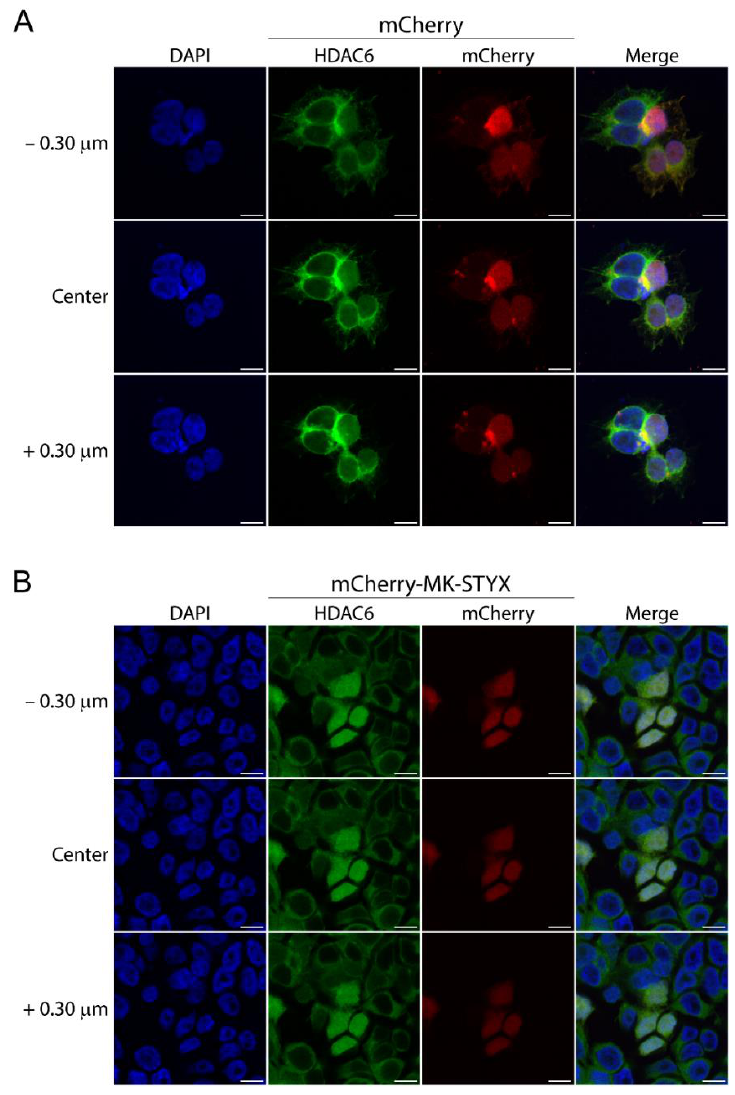
Figure 2. Confocal microscopy validates that the subcellular distribution of HDAC6 is altered in the presence of MK-STYX. ( A ) Representative examples of the subcellular distribution of endogenous HDAC6, detected with an anti-HDAC6 antibody (anti-HDAC6) and anti-rabbit conjugated to FITC in HEK/293 cells, cultured in the presence of serum and transfected with mCherry (control vector) or ( B ) mCherry-MK-STYX. Z-stacks at 0.15 µ m were performed by confocal microcopy, starting below the center of the cells. Representative images are shown above ( − 0.30 µ m) and below (+0.30 µ m) the center image. Scale bar, 10 µ m. Taking all fields of view into account, cell density was comparable for cells expressing mCherry and mCherry-MK-STYX. Representative images were chosen to illustrate the subcellular distribution of HDAC6.